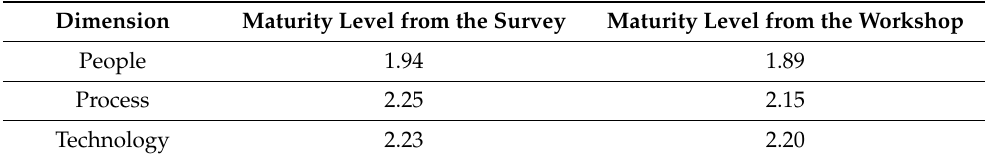
Table 4. Average maturity levels for unsuccessful technology implementation from survey and workshop validation.